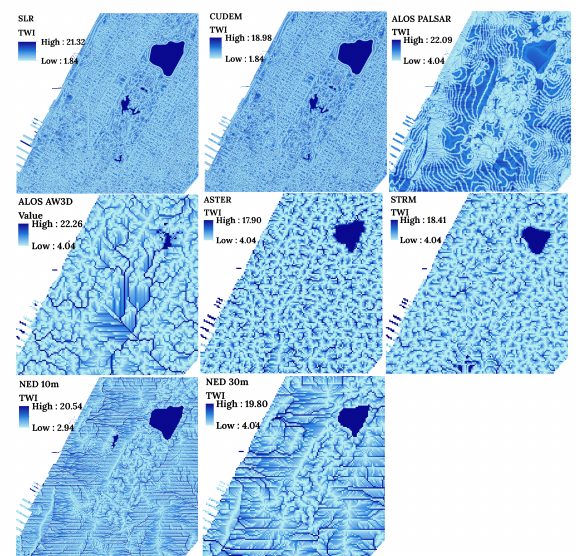
Figure 9. Generated Topographic Wetness Index map for Midtown Manhattan, New York city